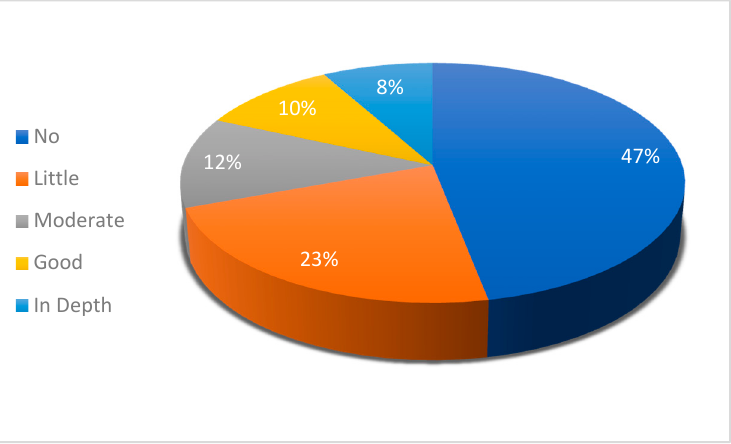
Figure 7. Consideration over the trustworthiness of data.